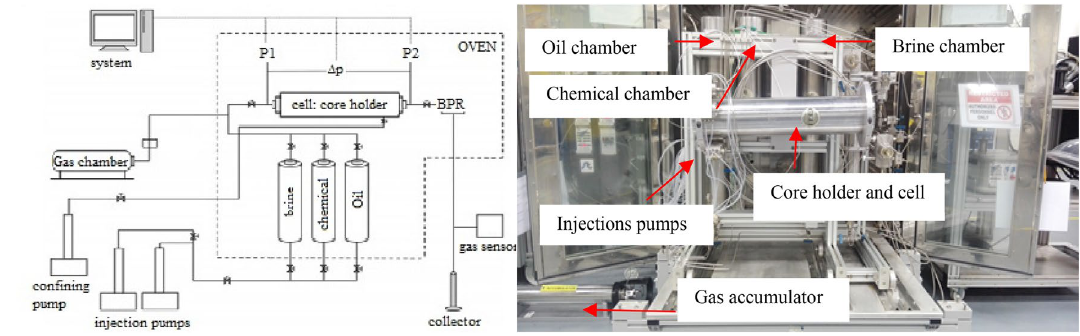
Fig. 1 Schematic diagram and image of the high-temperature high-pressure coreflood displacement equipment used